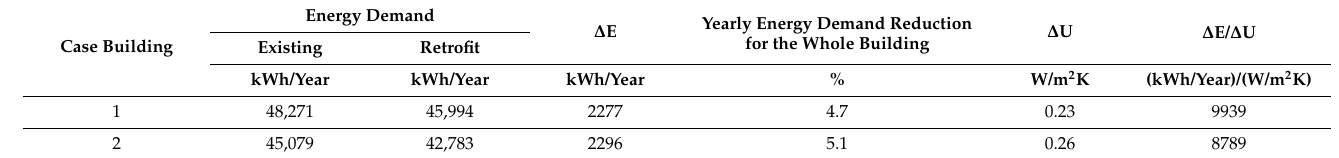
Table 6. Energy consumption before and after upgrading for the whole building for the OPPTRE